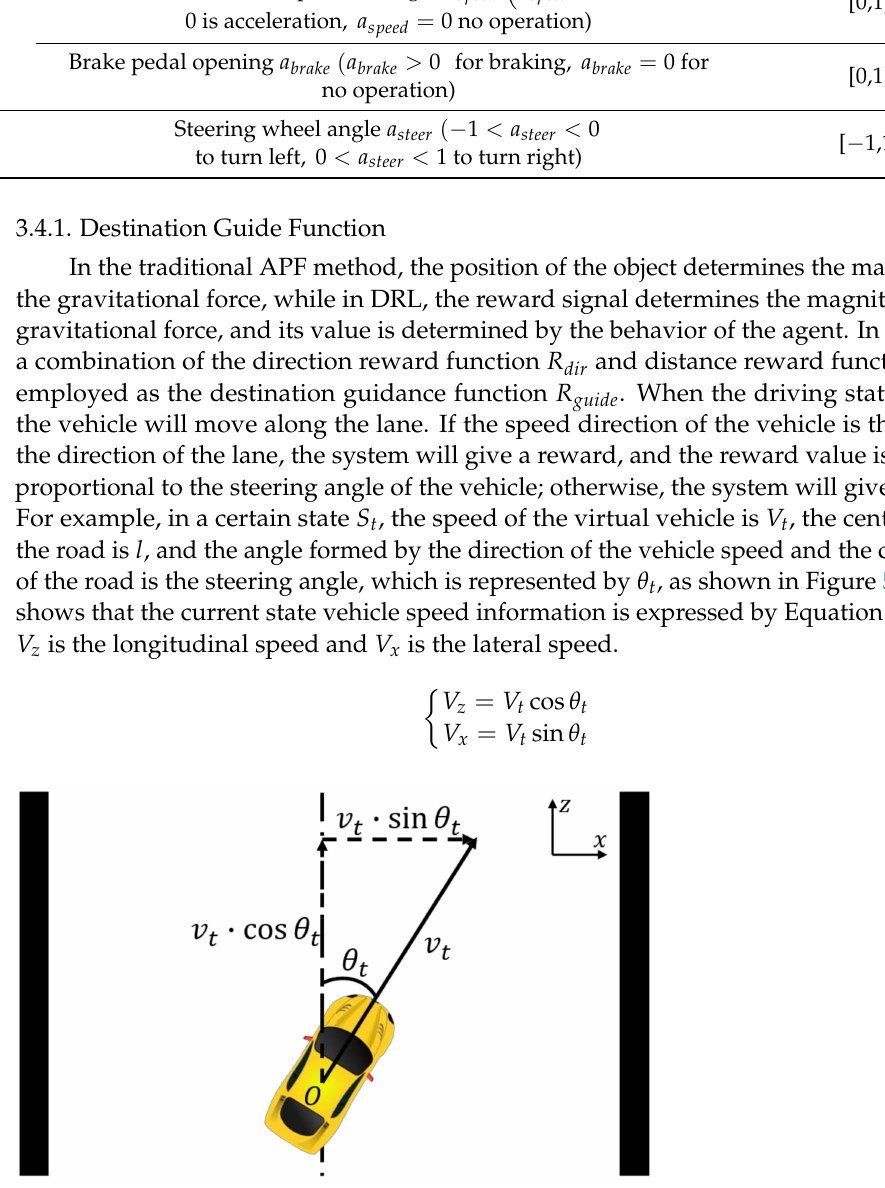
Figure 5. Schematic of the vehicle steering